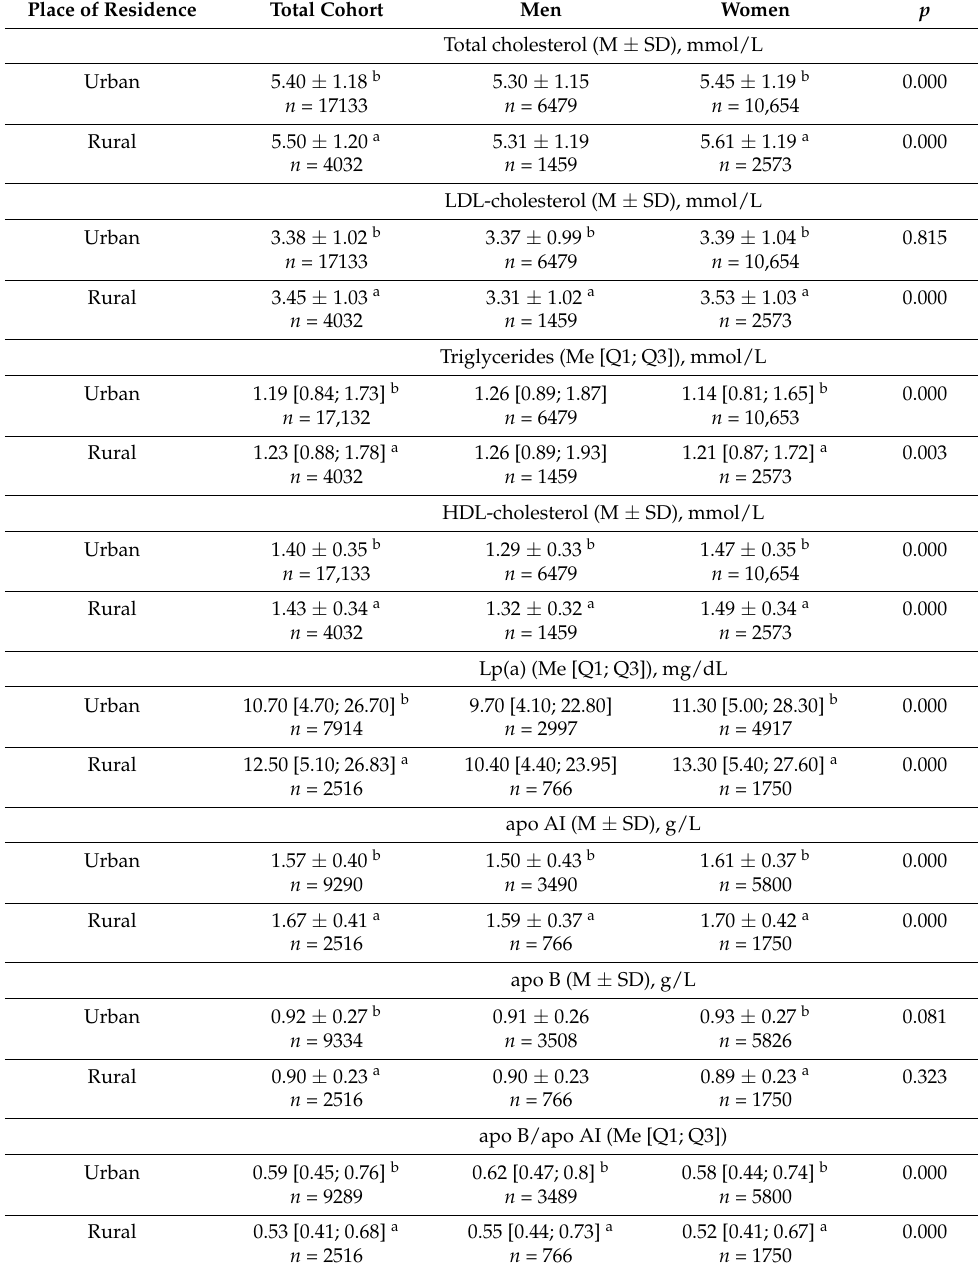
Table 2. Lipoprotein profile parameters in men and women differing in place of residence among populations from regions of the Russian Federation: ESSE-RF